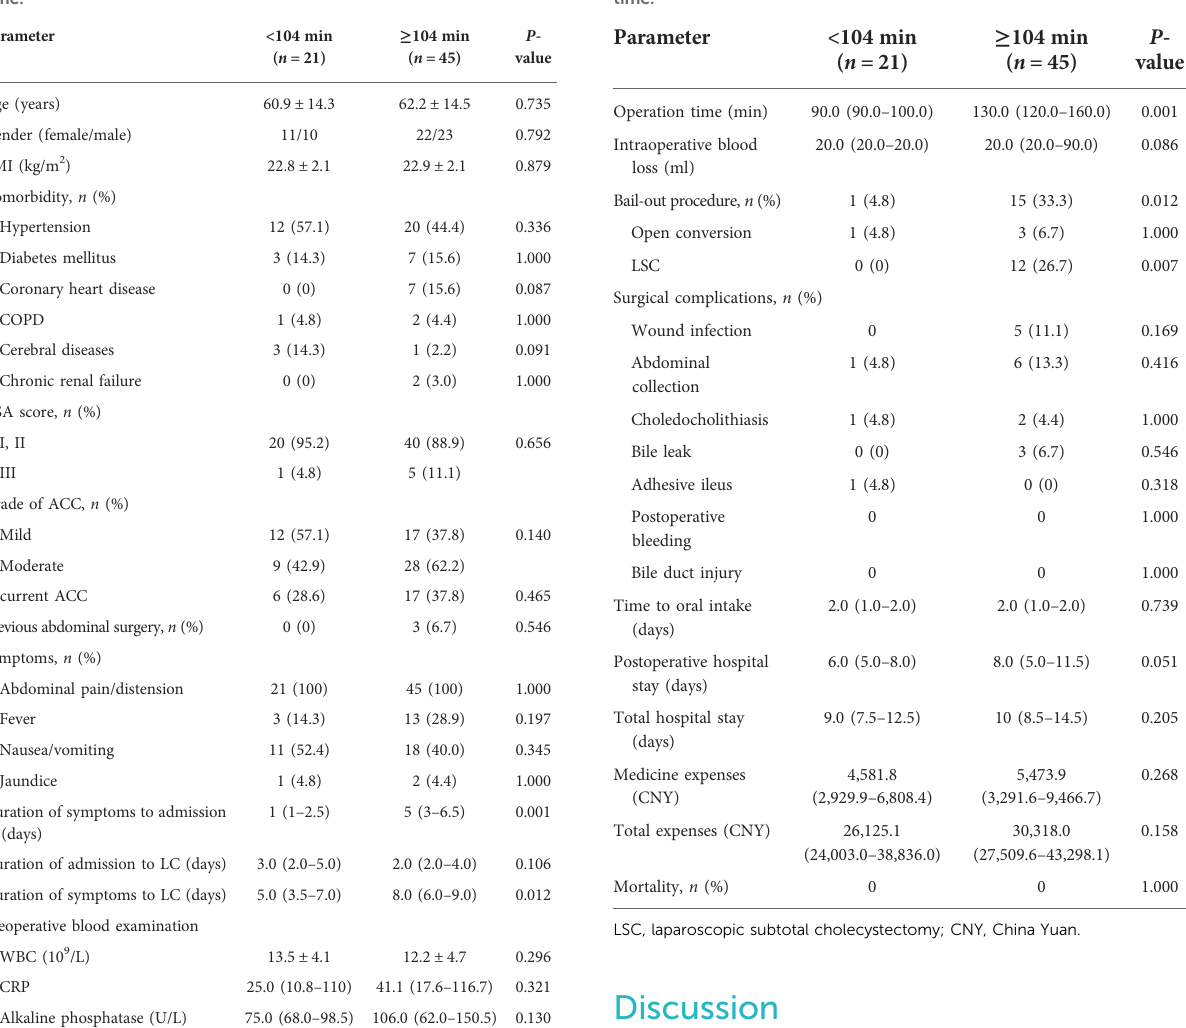
TABLE 4 Comparison of operative outcomes according to operation time.